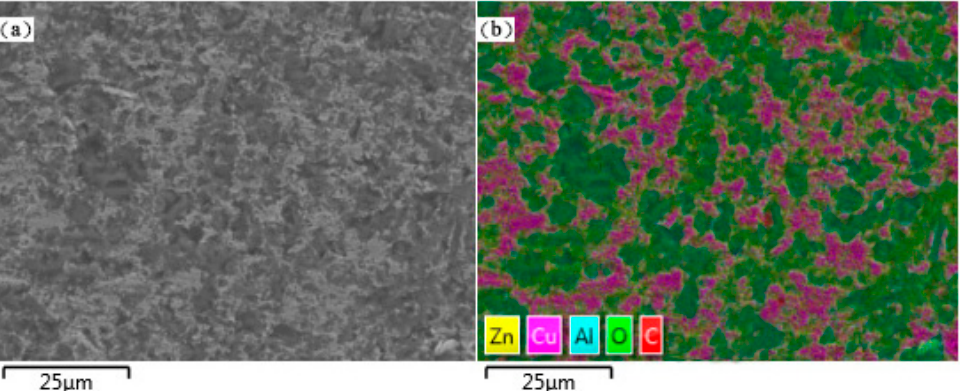
Figure 7. Cu distribution in the polished surface of Al 2 O 3 /30glass/30Cu f substrate perpendicular to the pressure direction: ( a ) Microstructure; ( b ) Distribution of Cu element marked by magenta.